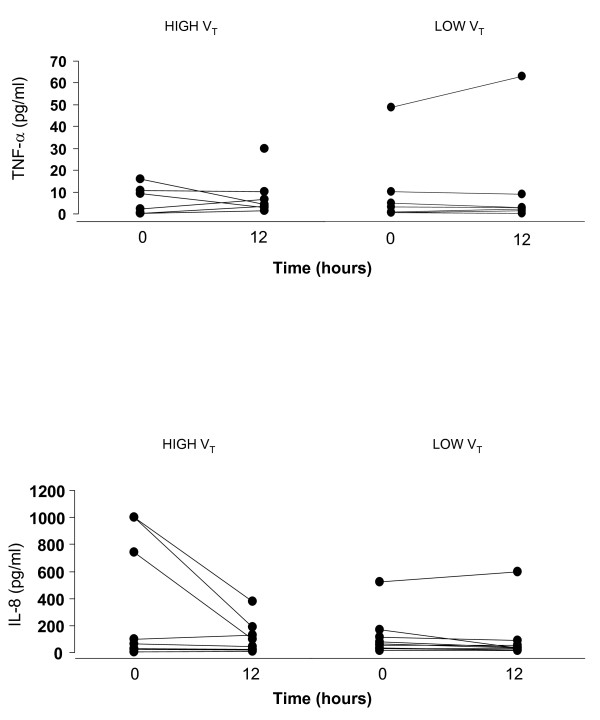
Time course of plasma TNF-α (top) and IL-8 (bottom) levels in high tidal volume (High VT) and low tidal volume (Low VT) groups.